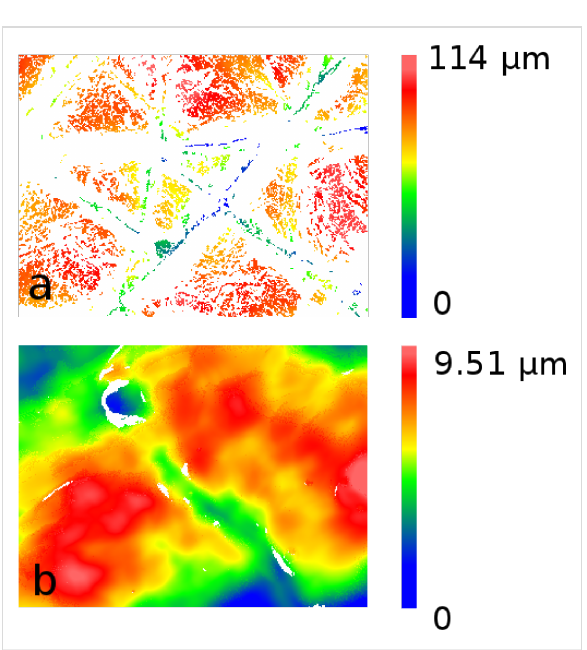
Figure 2: 3D surface profiles of a mould of wet human wrist skin obtained by using white light interferometry at low (a) and high (b) resolution (only the measured raw data are presented). The image width is 1.4 mm in (a) and 140 μ m in